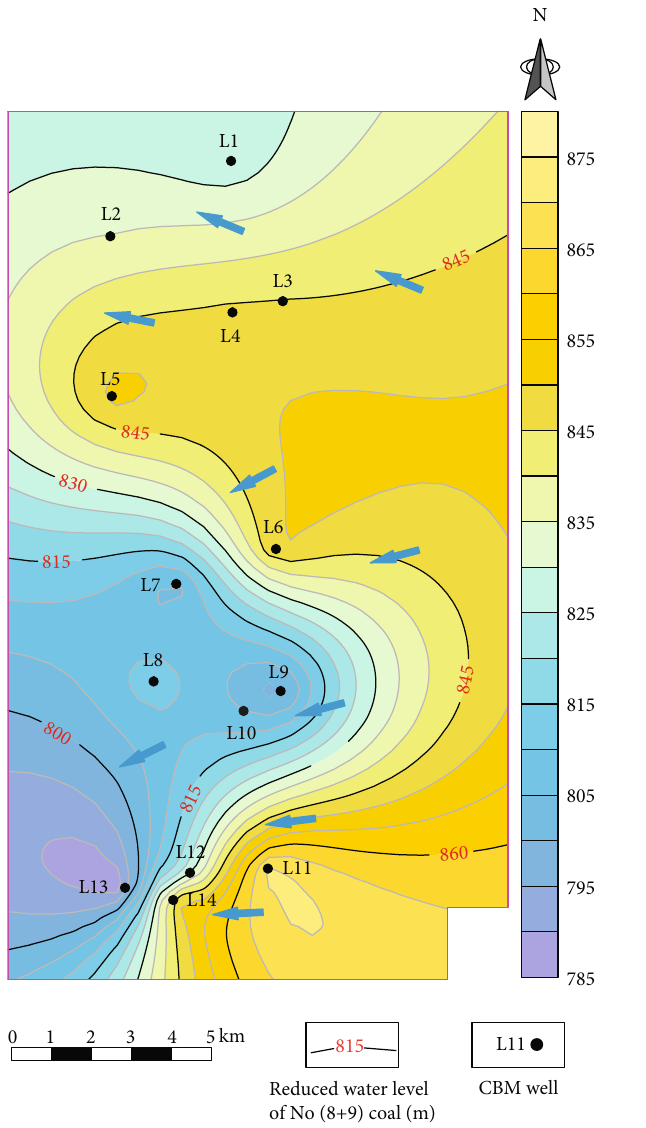
Figure 8: Contour map of reduced water level of No. ( 8 + 9 ) coal in Yangjiapo block.